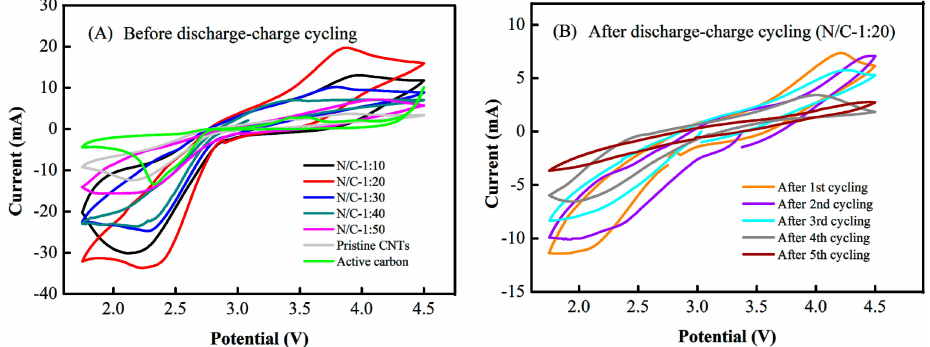
Figure 8. Cyclic voltammetry (CV) curves of Li–air batteries with ( A ) N-CNT arrays, pristine CNT arrays and active carbon as air electrodes, ( B ) the N-CNT arrays with N / C feed ratio of 1:20 as the air electrode at 0.1 mV s − 1 ,